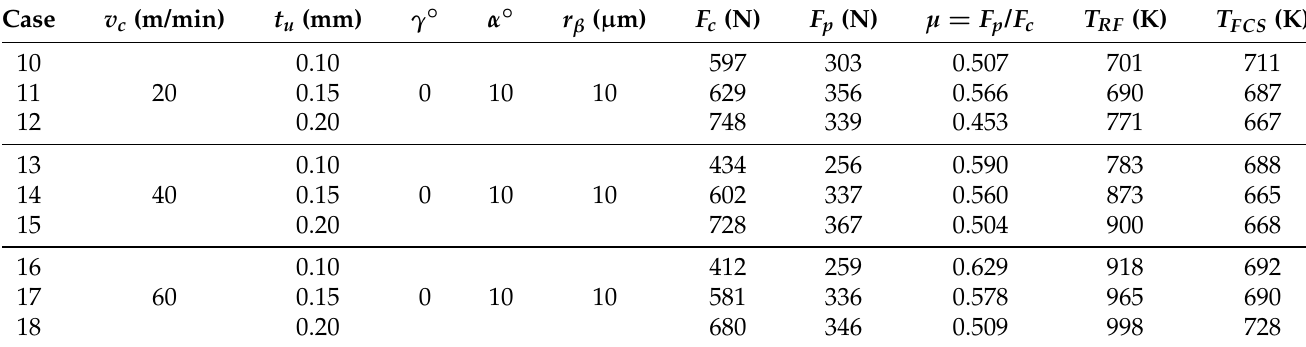
Table 3. Cutting experiments data for